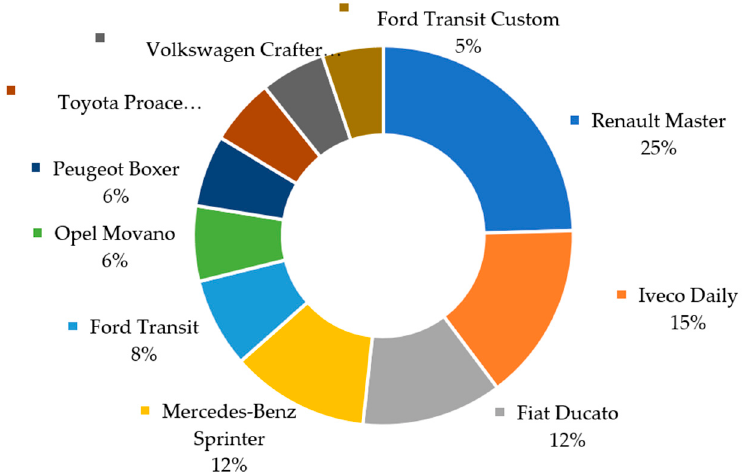
Figure 15. The most popular models in terms of the number of new registered N1 commercial vehicles in Poland in 2021 [21].